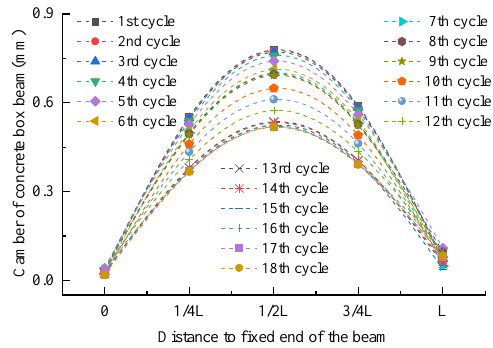
Figure 17. Camber of the beam along the longitudinal direction.